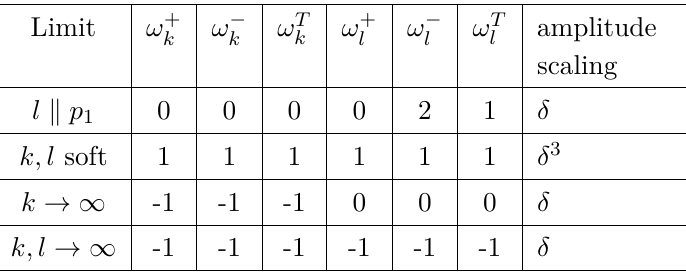
Table 3. The scaling behavior of the fermion box contributions to the finite integrand f M (2) various limits. The loop momenta k and l are parameterized as eq. (6.5), with the scaling exponents given in this table. The scaling of the integration measure has been taken into account. Since the integrals always scale as δ raised to a positive power, there is no divergence in any of the IR / UV